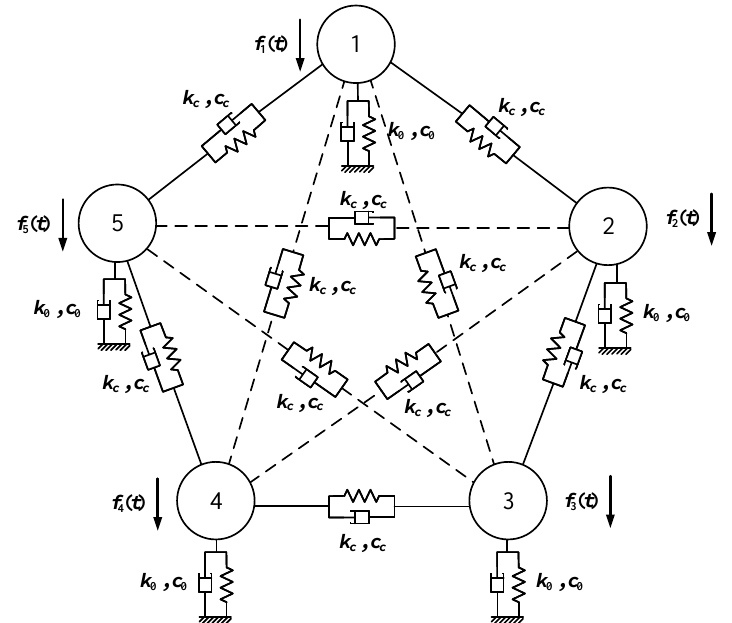
Figure 3. Schematic of five-sensor mechanical coupled structure. The coupling exists between each pair of